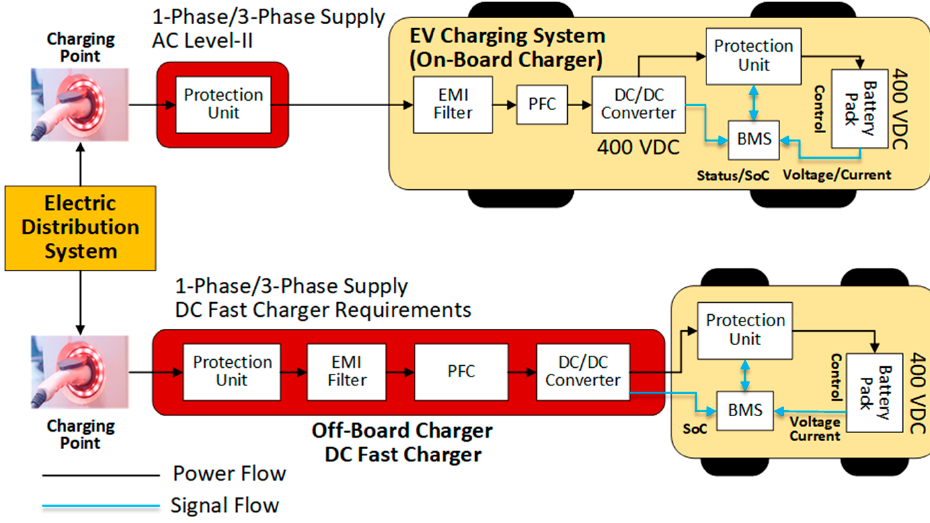
Figure 1. On-board and off-board charging systems [16].